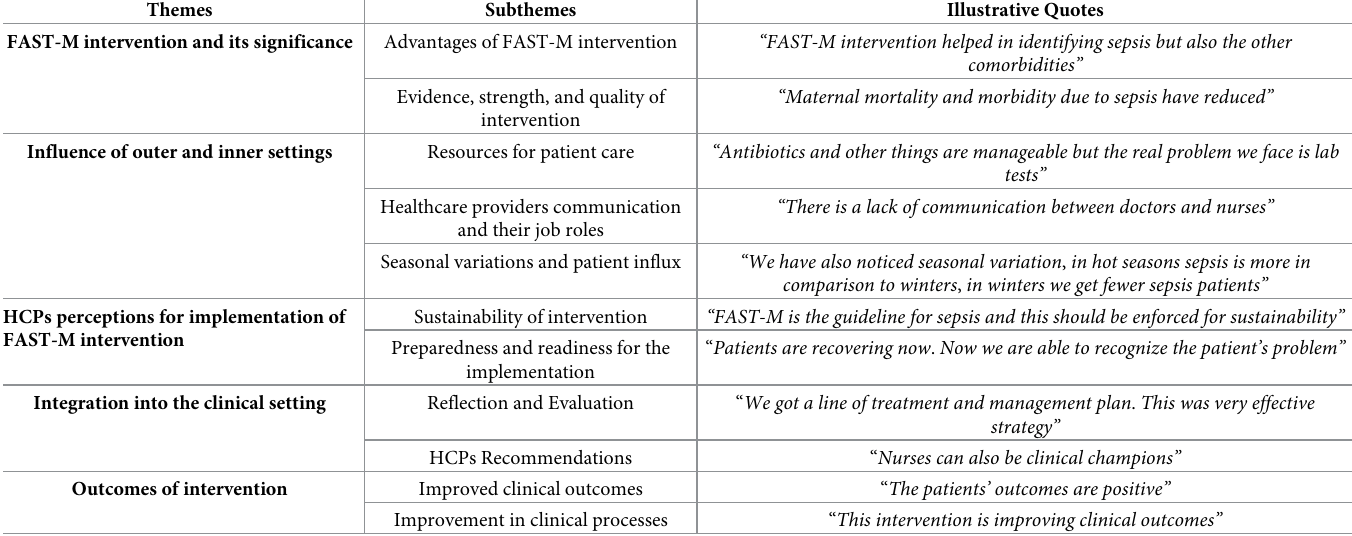
Table 5. Themes and